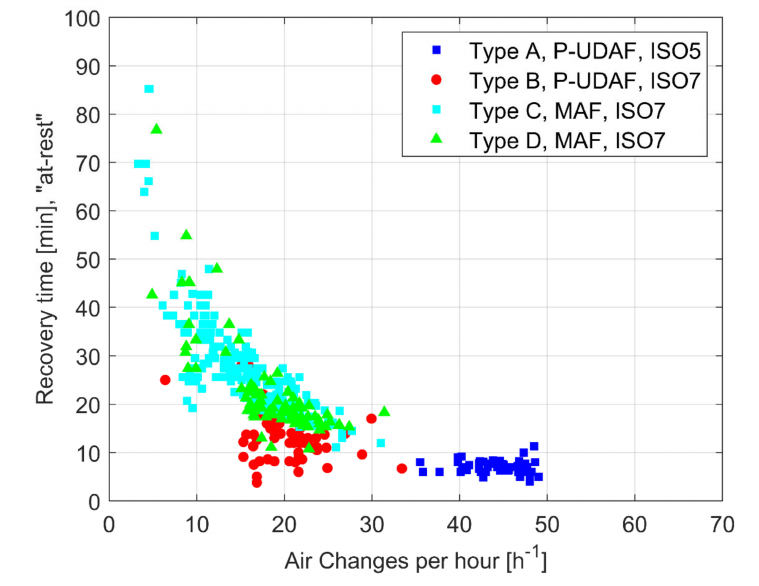
Figure 3. Recovery Time vs. ACH in “at-rest” conditions. Values of the 175 investigated OTs.